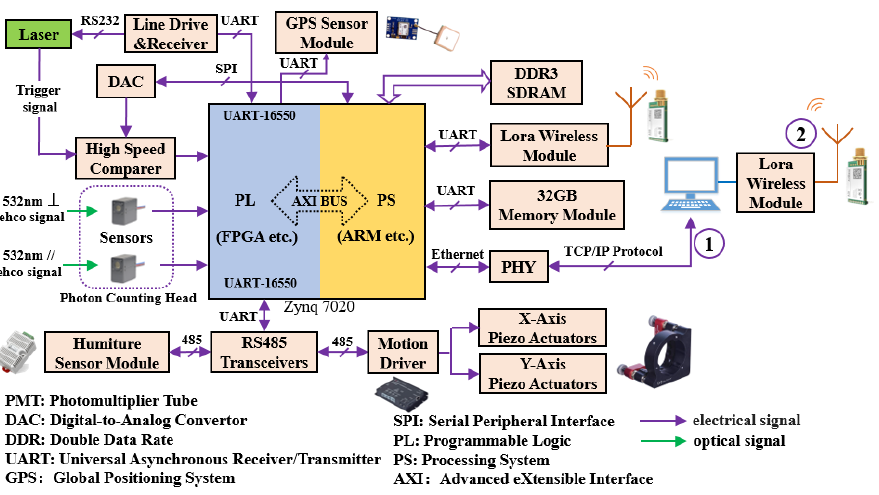
Figure 2. Block diagram of DALCS hardware structure.